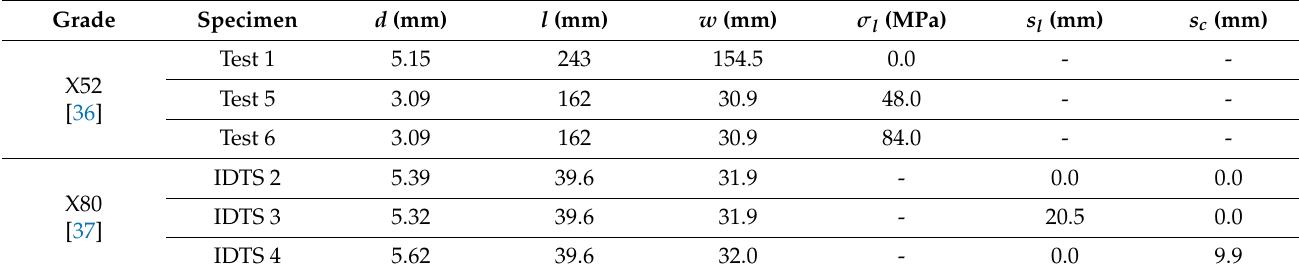
Table 6. Summary of burst test details by Bjorney et al. and Benjamin et al.